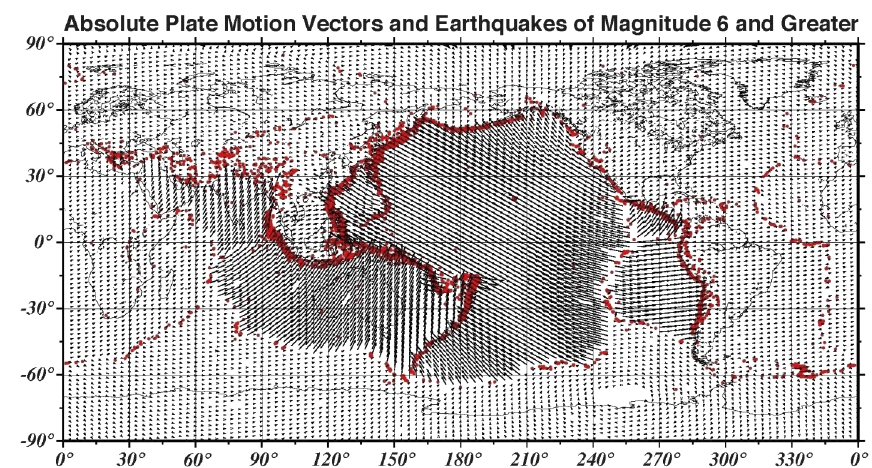
Figure 8. Absolute plate velocity vectors (1 per 1000 plotted black arrows) for the 52 plates of Bird (2003) and earthquake locations with magnitudes greater than magnitude